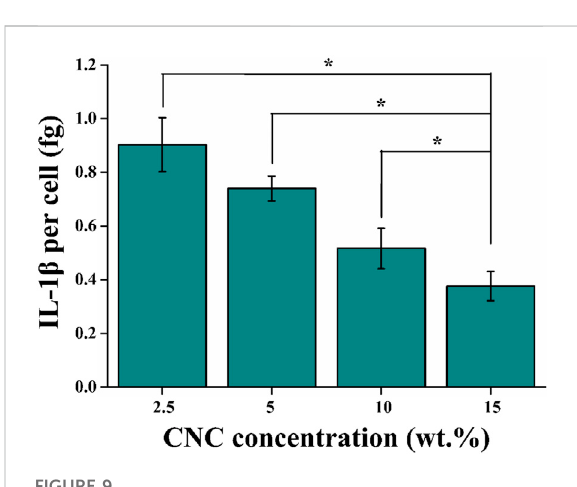
FIGURE 9 Quanti fi cation of the amount of IL-1 β secreted into the different viscoelastic hydrogels after 14 days of culture (* p <